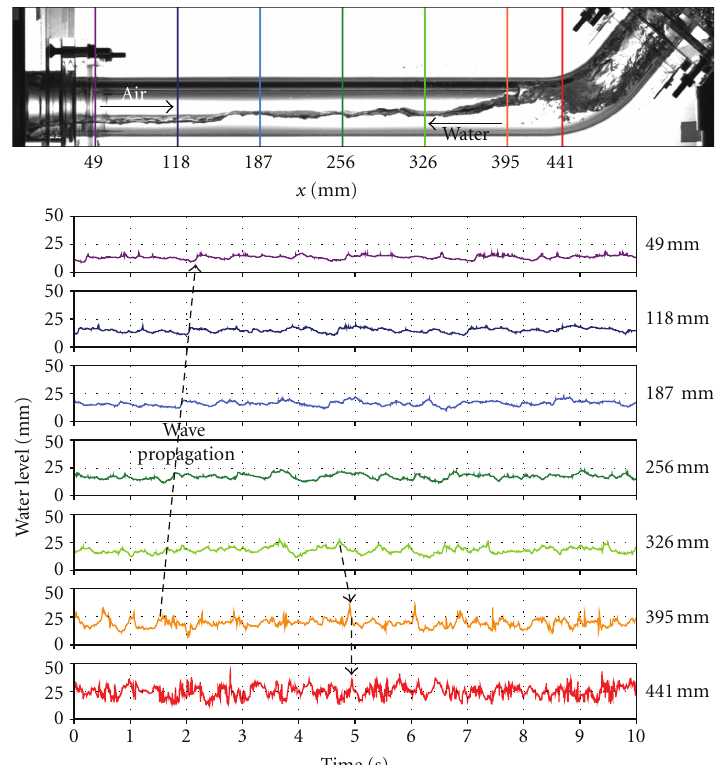
Figure 6: Time-dependent water level in chosen cross-sections during CCFL at j L ,in = 0.25m/s and j G = 4.0m/s.